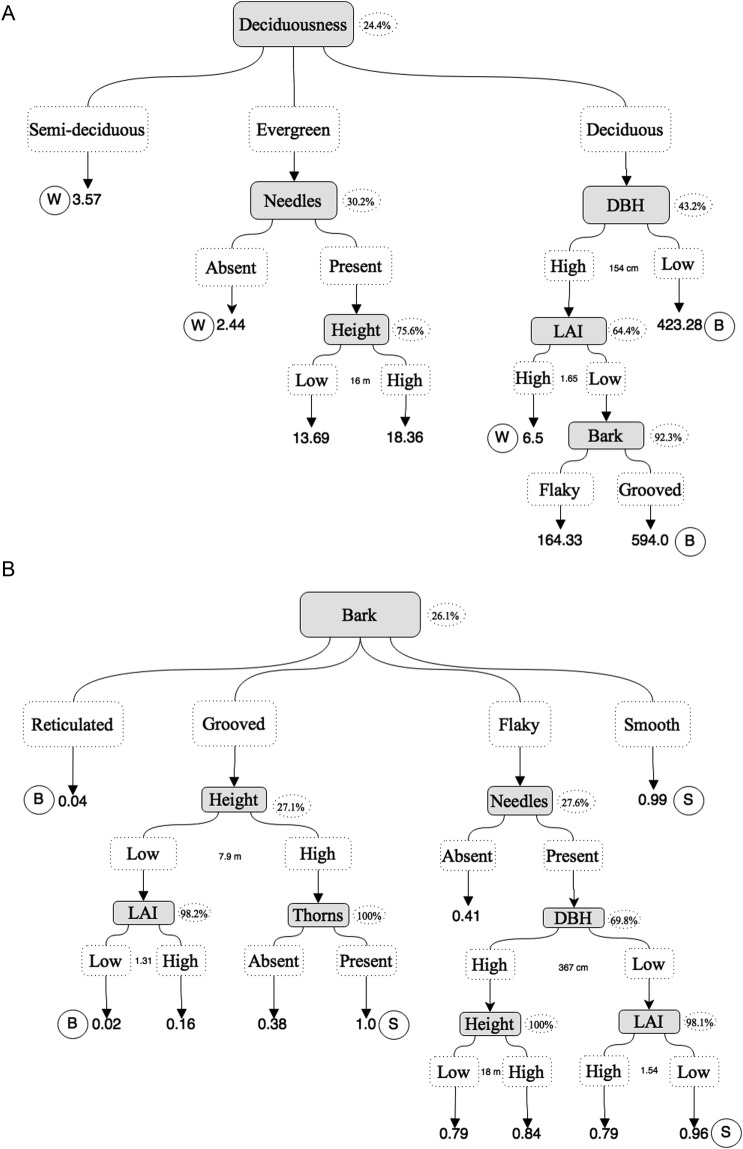
Data trees of the successive hierarchic partitions for (A) ABabund and (B) ABdst variances, showing the tree trait interactions. The grey rectangles represent a trait that best explained (percentage of variance explanation are showed in dotted ellipses) the variance of a group formed by a previous hierarchic partition (when preceded by an arrow). White and dotted rectangles represent the groups formed by the most explanatory trait (just above). Values between some of the white and dotted rectangles represent the median value of quantitative traits, on which the groups were formed. The values indicated by the last arrows are the mean of ABabund (A) and ABdst (B) of the groups formed by the trait interactions of all significant hierarchic partitions. The circles indicated the patterns of trait interactions that were named as best, worst, branches or trunk hosts (specifically B and W (A); or B and S (B)).